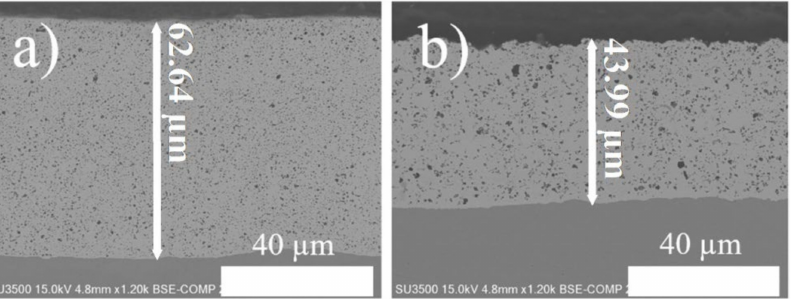
Figure 5. Cross-sectional SEM images of Ni–W/B coatings ( a ) prepared by pulse current with a peak current density of 0.2 A/cm 2 , frequency of 100 Hz, and 50% duty cycle, ( b ) prepared by direct current with a current density of 0.1 A/cm 2